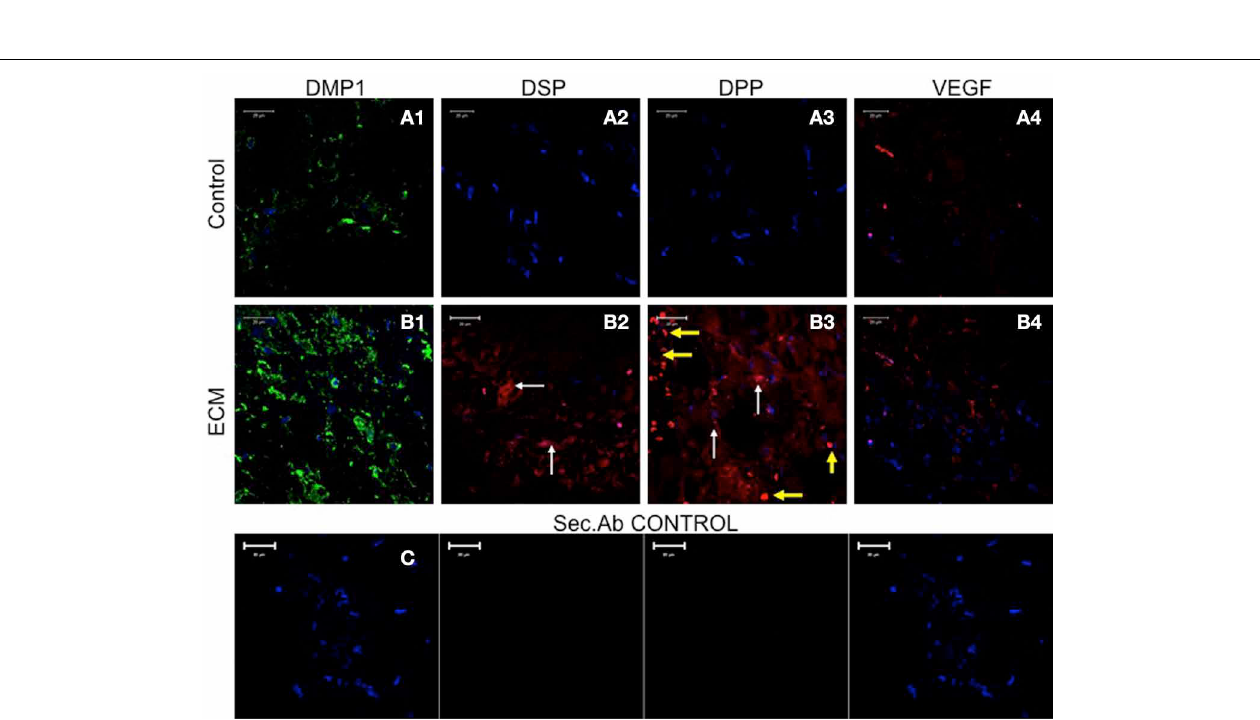
FIGURE 7 | HMSC immunohistochemistry. The fluorescent images are representative confocal micrographs of sections from HMSC seeded scaffold explants consisting of control collagen/chitosan scaffold (A) and pulp ECM scaffold (B) . The sections were analyzed for the expression of DMP1 (A1,B1) , DSP (A2,B2) , DPP (A3,B3) , and VEGF (A4,B4) . Note the absence of DSP and DPP signal in (A) (control scaffolds containing HMSCs). White arrows in (B) point to positive staining of the same by